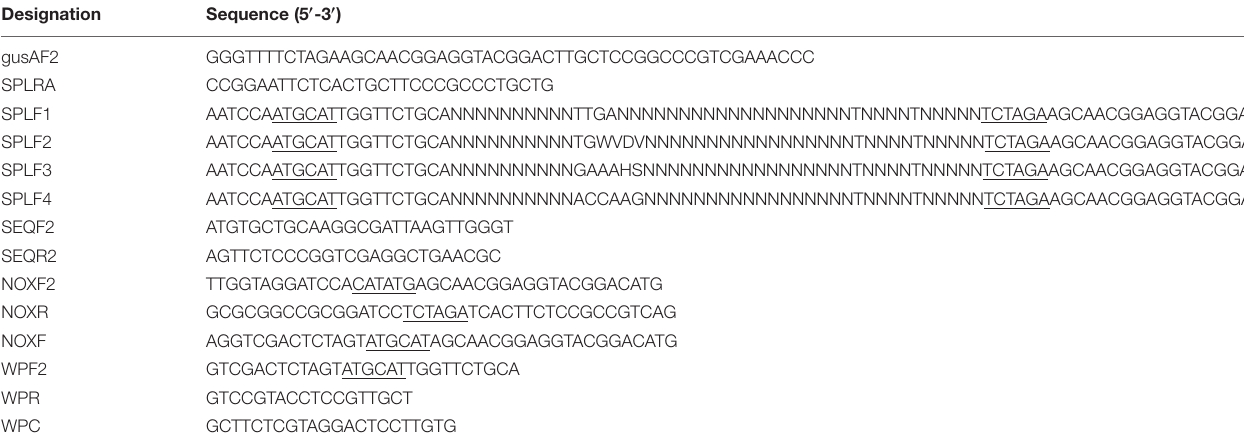
TABLE 2 | Primers used in this